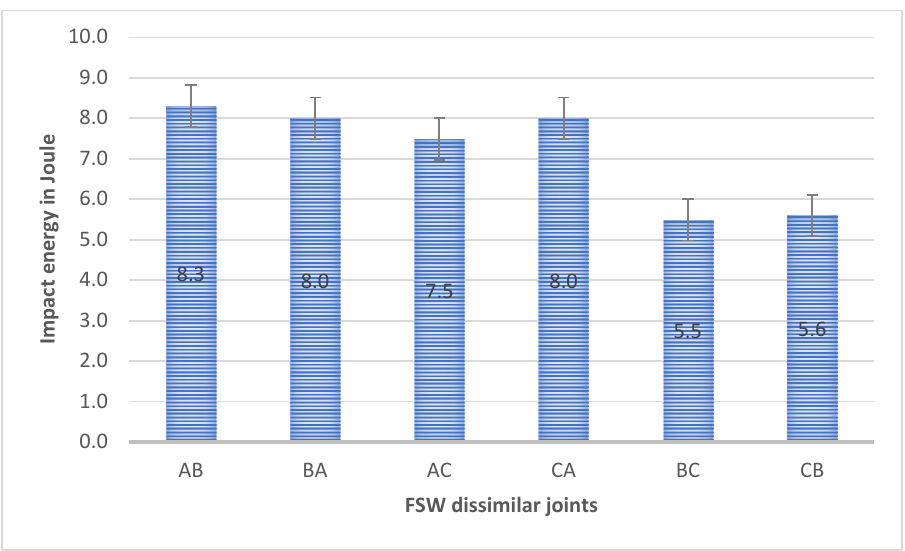
Figure 4. Impact energy of dissimilar butt joints.